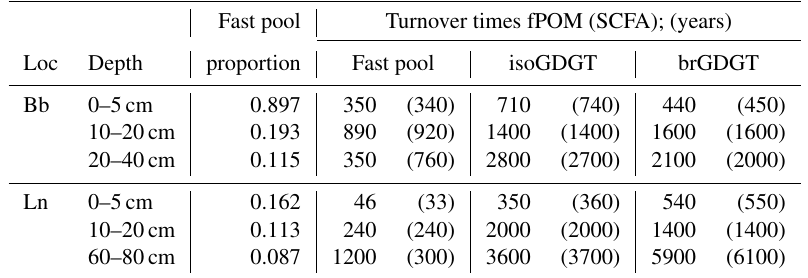
Table 1. Turnover times of isoprenoid and branched GDGTs. Turnover times are based on the single-pool turnover time of the light fraction (fPOM) or the short-chain fatty acids (SCFA – in parentheses) as approximation of the fast pool. Note: Loc –